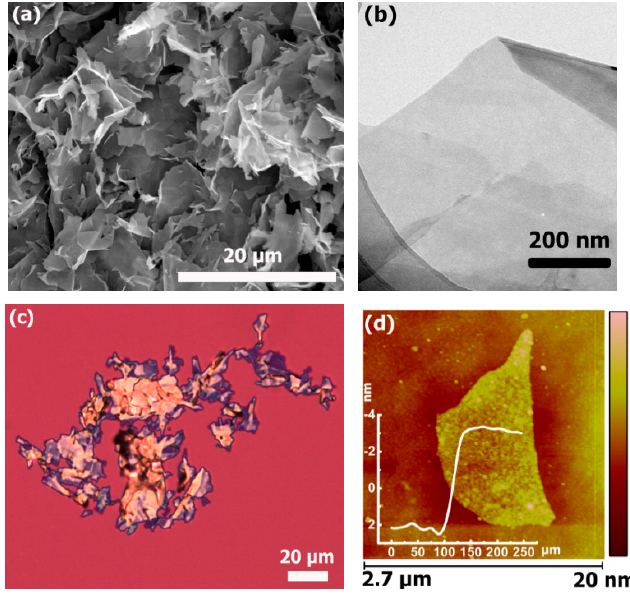
Figure 1. The characterization of GNPs: ( a ) SEM; ( b ) TEM image of individual GNPs; ( c ) OM and ( d ) AFM.